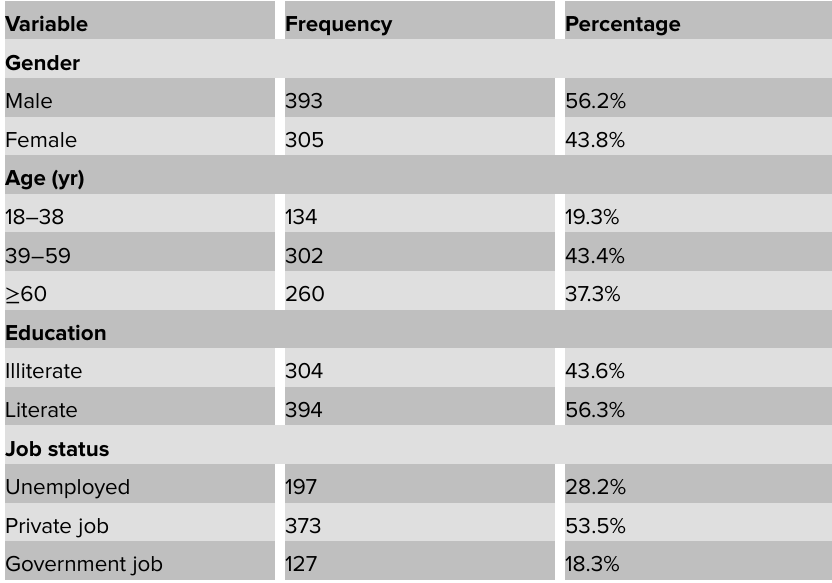
TABLE 1: Demographic